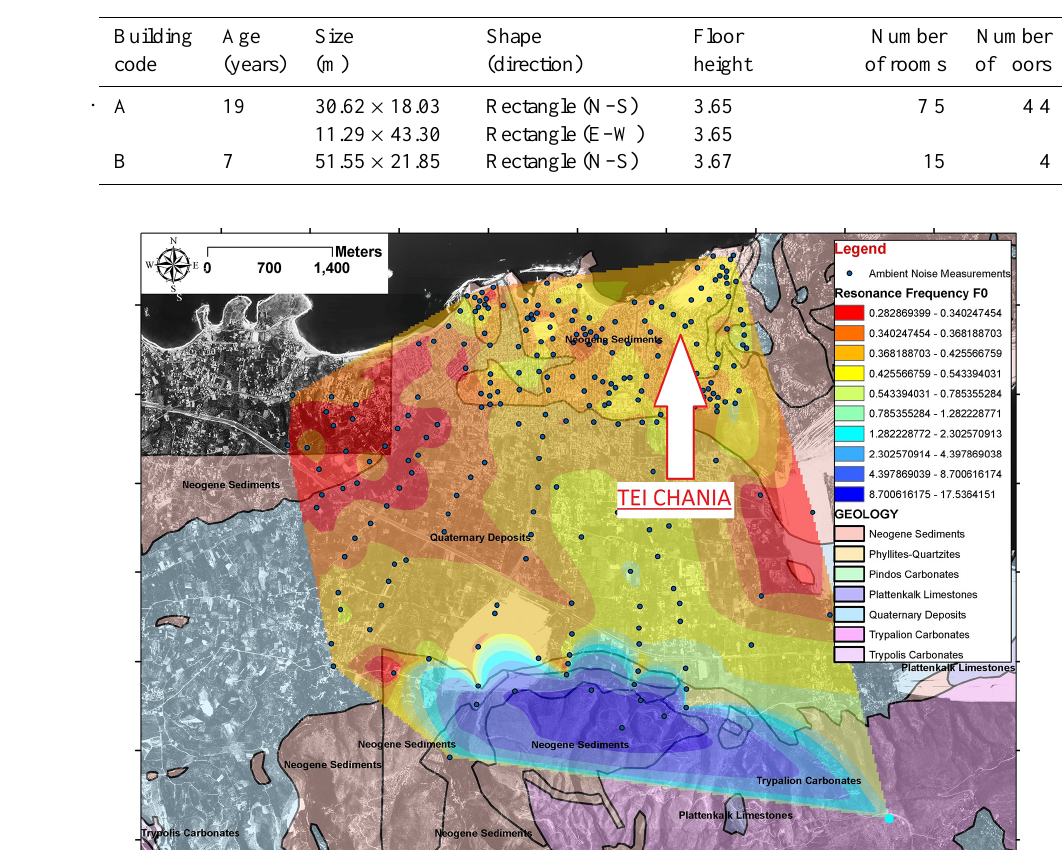
Figure 4. Case study building location is indicated. This map presents frequency of recorded HVSR for the broader area of Chania (Pa- padopoulos,